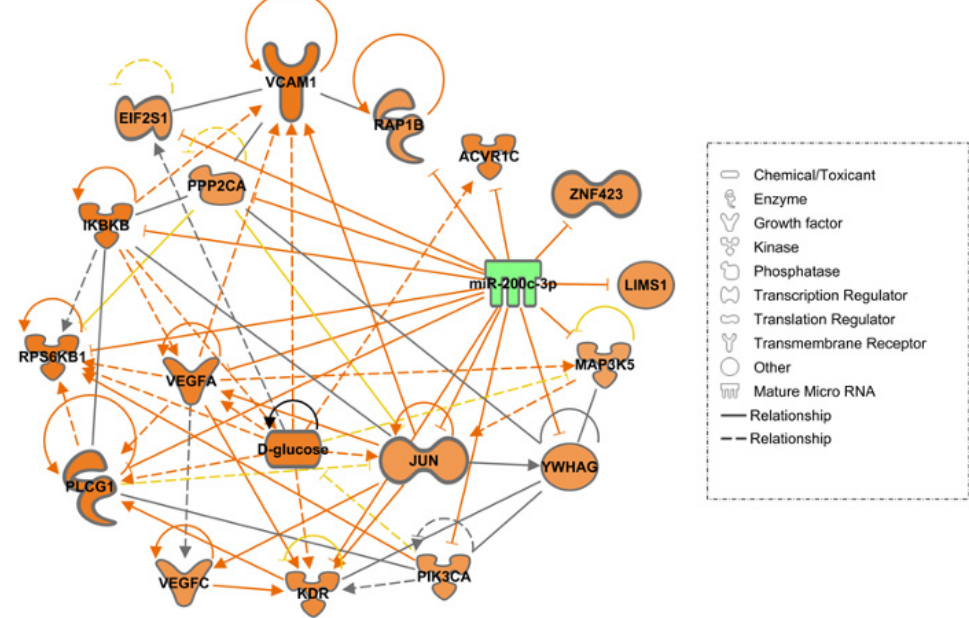
Figure 5. Ingenuity Pathway Analysis (IPA) prediction network of miR-200c-3p using our data and its mRNA targets, supporting its involvement in cardiovascular disease. Three pathways were considered relevant in this study: the PI3K-Akt signaling pathway, the Hippo signaling pathway, and the VEGF signaling pathway. The green color denoted decreased measurement, and the orange color denoted upregulation or predicted activation. The lines colored in orange represented stimulation, blue inhibition and grey effect not predicted. Solid lines represented a direct relationship, whereas dashed, interrupted ones represented an indirect relationship. Genes outlined with blue are involved in VEGF signaling, while ones outlined in dim gray are involved in PI3K/Akt signaling